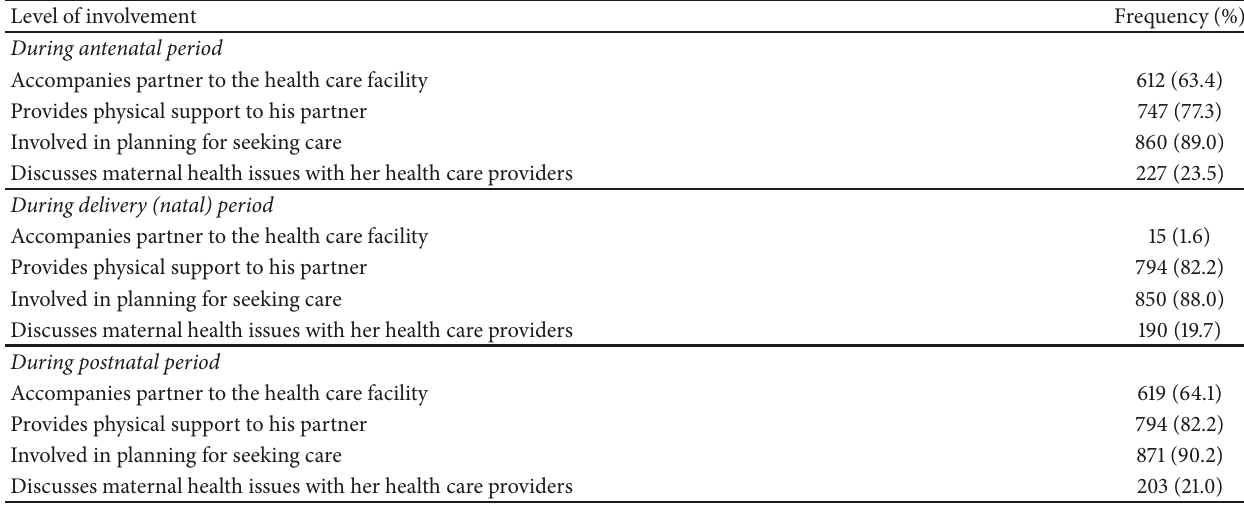
Table 2: Proportion of respondents involved in the four activities used to measure the level of men’s in maternity care. Level of